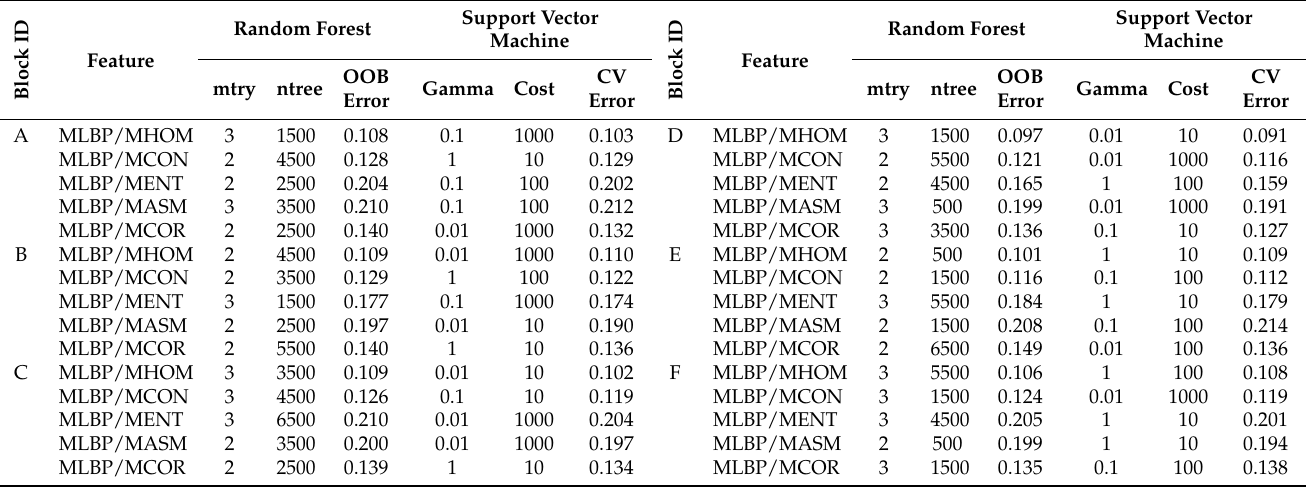
Table 3. The RF and SVM model optimisation parameters of the multivariate local binary pattern (MLBP) model.